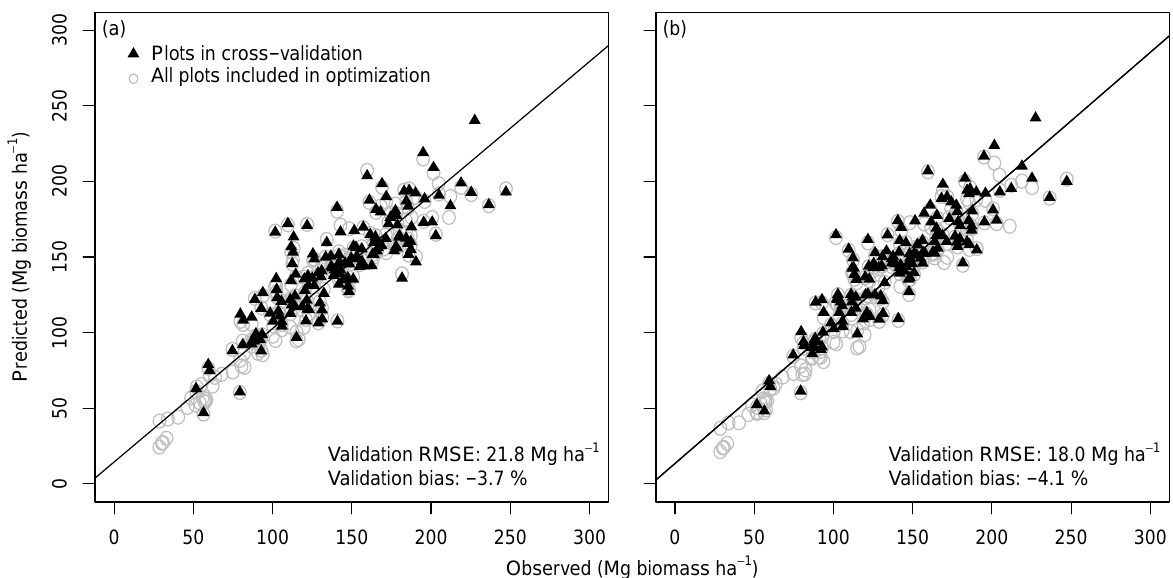
Figure 4. Model evaluation of stem biomass when assimilating (a) observations across environmental gradients and ecosystem manipulation experiments (Base; Table 4) and (b) only observations across environmental gradients (NoExp; Table 4). The gray circles correspond to predictions where all plots were used in data assimilation. The black triangles correspond to predictions where 160 plots were not included in data assimilation and represent an independent evaluation of model predictions (cross-validation). For each plot, we used the measurement with the longest interval between initialization and measurement for evaluation.